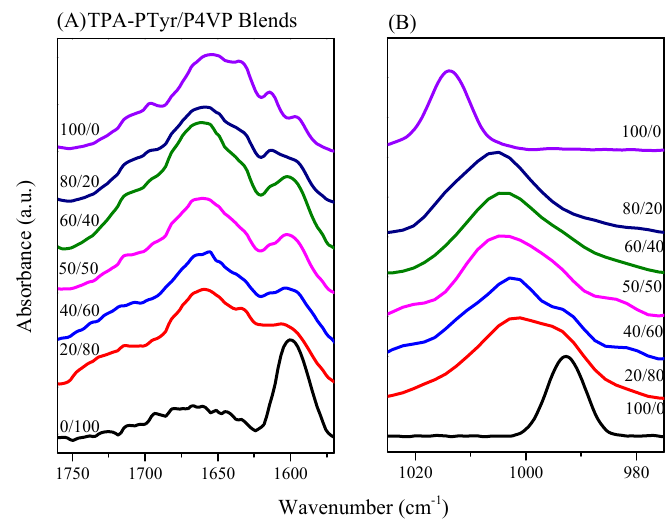
Figure 10. FTIR spectra, recorded at room temperature, of the miscible PTyr-TPA/P4VP blends in the regions: ( A ) 1760–1570 cm − 1 (amide I absorption); and ( B ) 1030–970 cm − 1 (pyridine unit absorption).